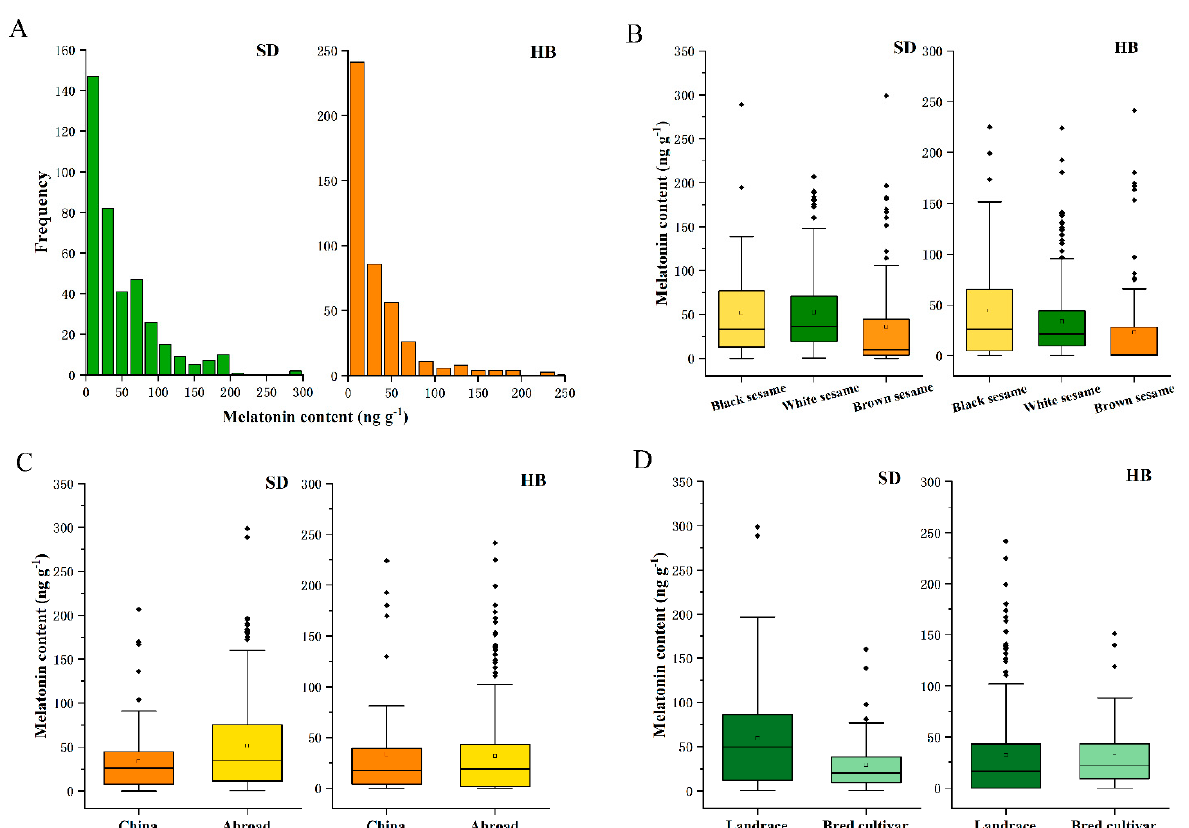
Figure 1. ( A ) Distributions of melatonin contents in sesames from SD and HB. ( B ) The melatonin content of different seed colors is shown in boxplot graph. ( C ) The boxplot graph of melatonin content from China and abroad. ( D ) The melatonin content of landrace and bred cultivar in boxplot graph.